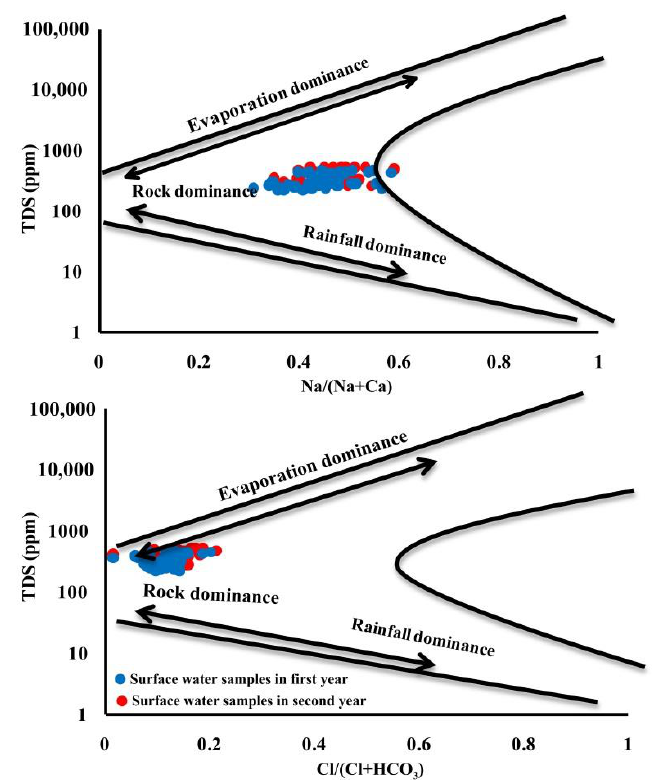
Figure 2. The geochemical controlling factors for surface water samples over two years according to the Gibbs Diagram.